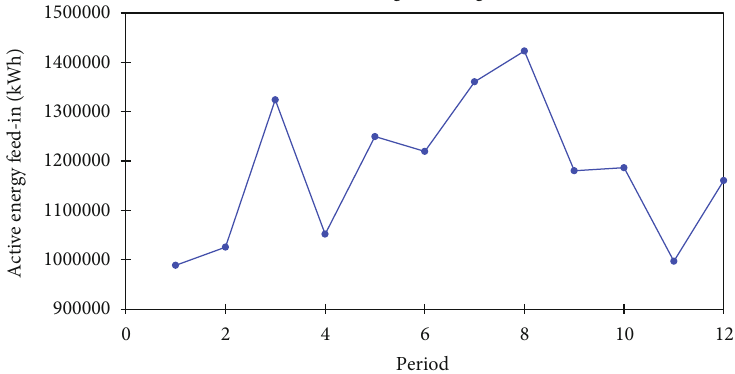
Figure 3: Seasonal Mann-Kendall Trend Test analysis of active kWh energy feed-in in the national grid during 2015.